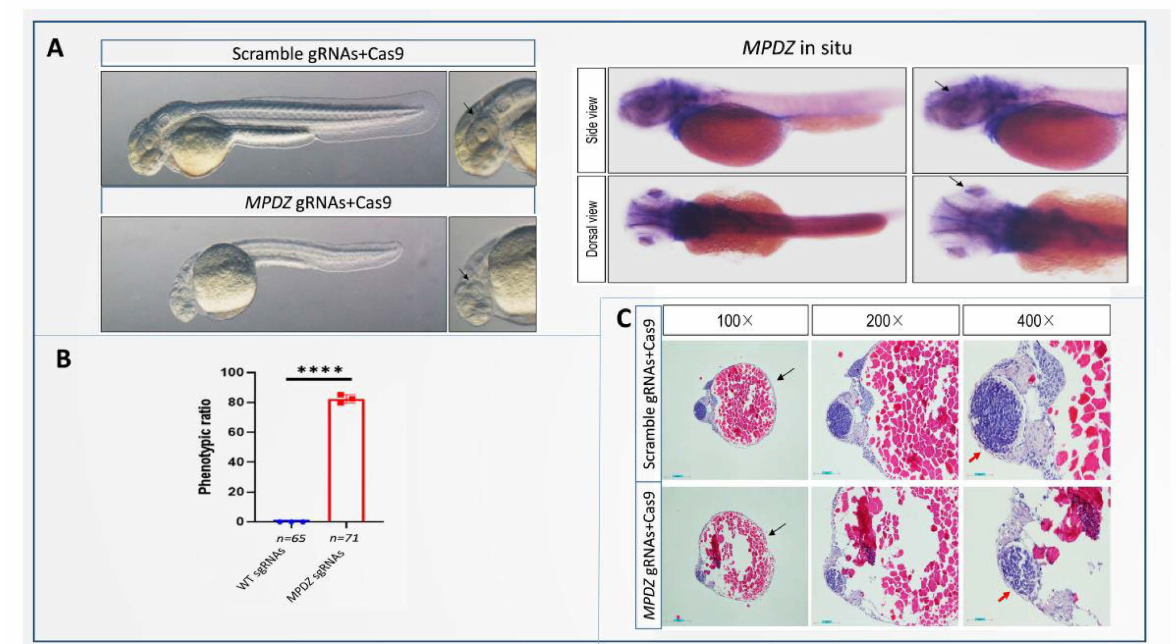
Figure 4. Experiment on zebrafish. ( A ) MPDZ crispant zebrafish displayed reduced eye area and body length compared to wildtype zebrafish. The phenotype of the MPDZ -knockdown crispants was more obvious compared to that of the wildtype. ( B ) Phenotypic ratio indicating the percentage of fish that uniformly showed reduced eye area and body length. The percentage of phenotypic positive fish in the MPDZ gRNA group ( n = 71) was significantly greater than that in the WT gRNA group ( n = 65) ( p < 0.05). ( C ) Histological examination showing a series of phenotypes, including a small eye and a thin